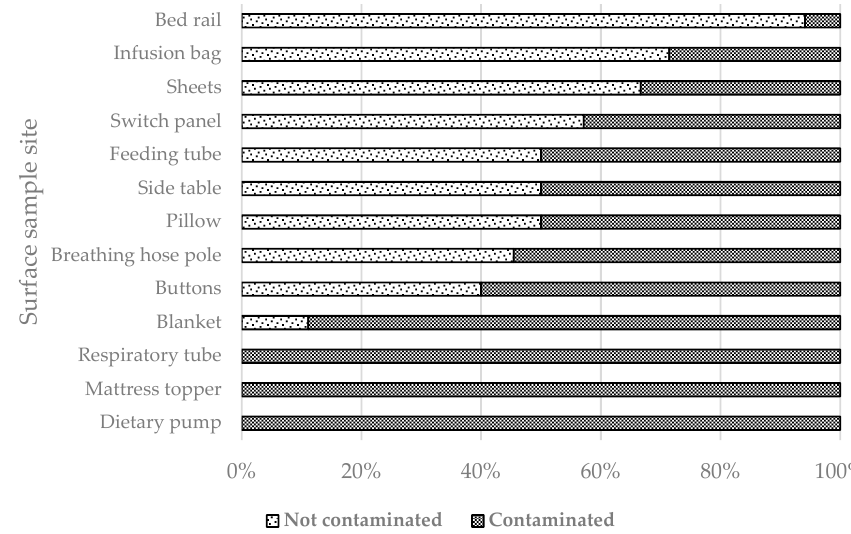
Figure 1. Staphylococcus aureus contamination of the environmental samples, according to the percentage of contaminated versus non-contaminated